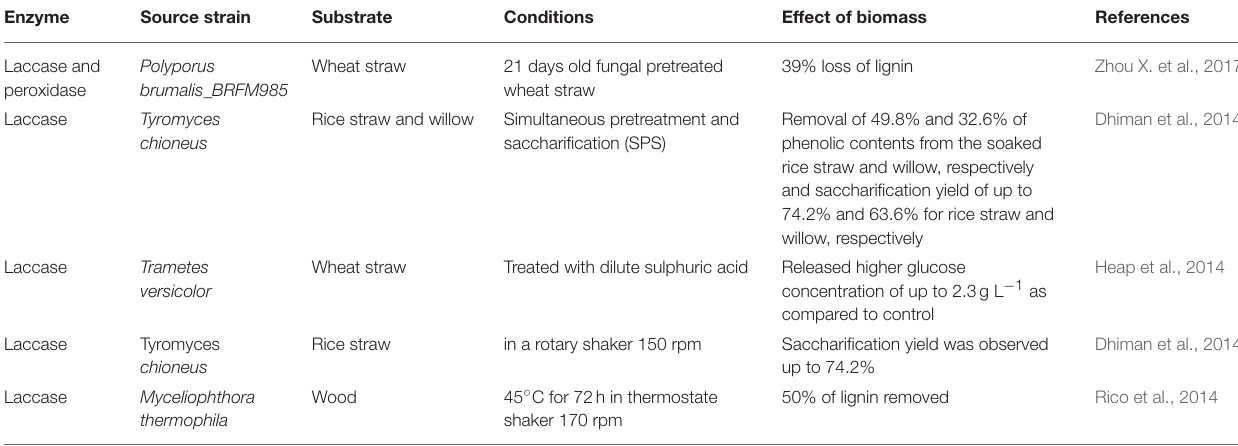
TABLE 4 | Effect of enzymatic pretreatment on different lignocelluloses.